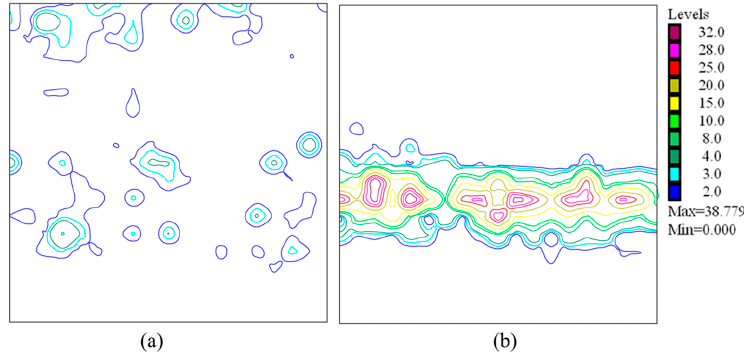
Figure 8. Average grain size of 70% clock-rolled Ta when annealed at 1050 °C for 120 min. Note that “all grains” mean the grains with all orientations in the OIM. Metals 2019 , 9 , x FOR PEER REVIEW